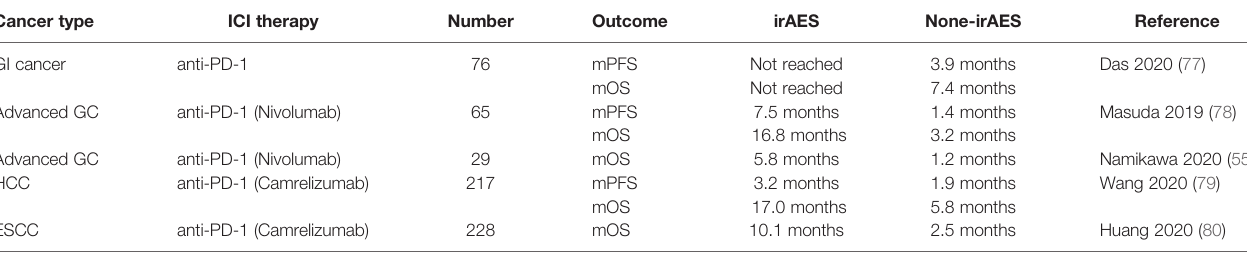
TABLE 5 | Predictive performance of irAES for response to ICI therapy for digestive system